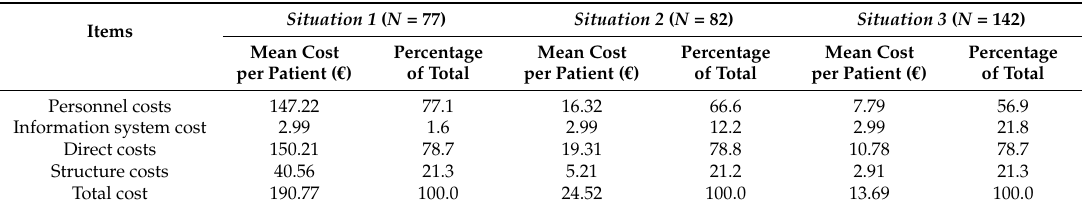
Table 5. Mean costs associated with systematic screening for occupational exposure in patients with lung cancer (microcosting